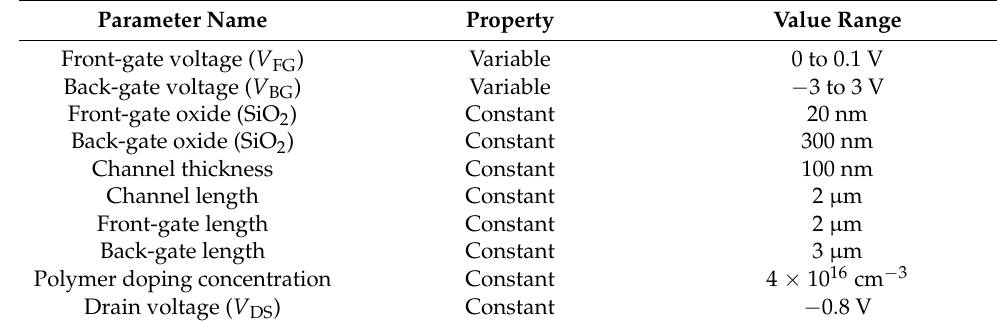
Table 1. Important physical parameters used in the present simulation.